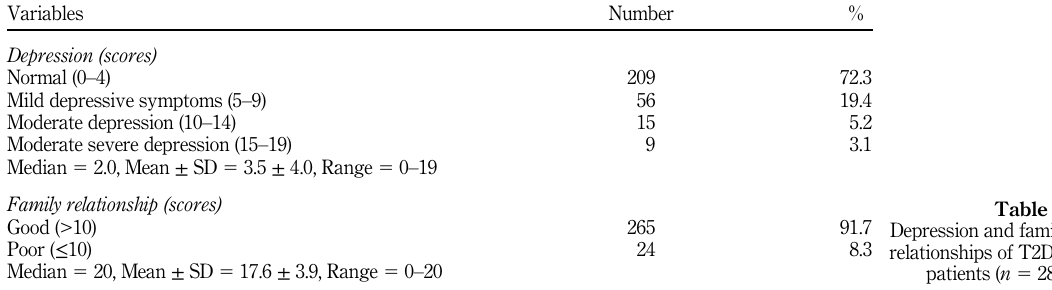
Table 3. Depression and family relationships of T2DM patients ( n 5